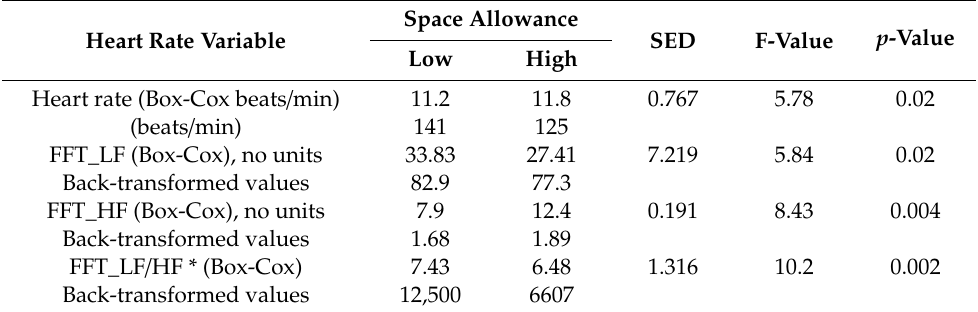
Table 4. Significant e ff ects ( p < 0.05) of low and high space allowance treatments on heart rate and its variability on sheep ( n = 6) in simulated sea